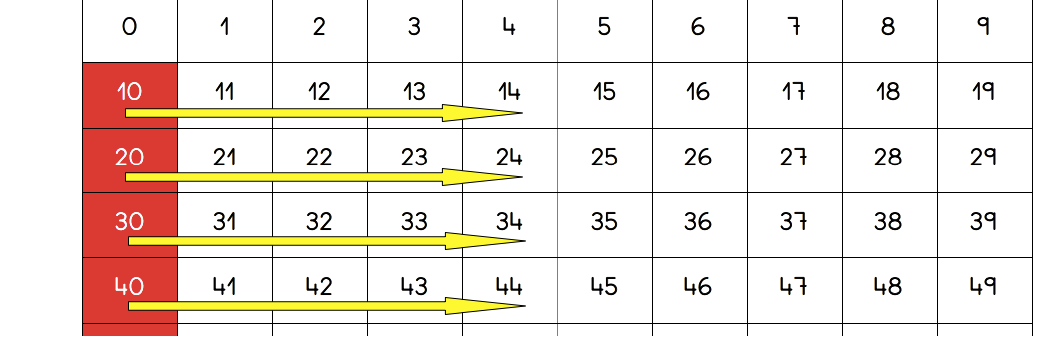
Figure 12. Panel with some operation represented.